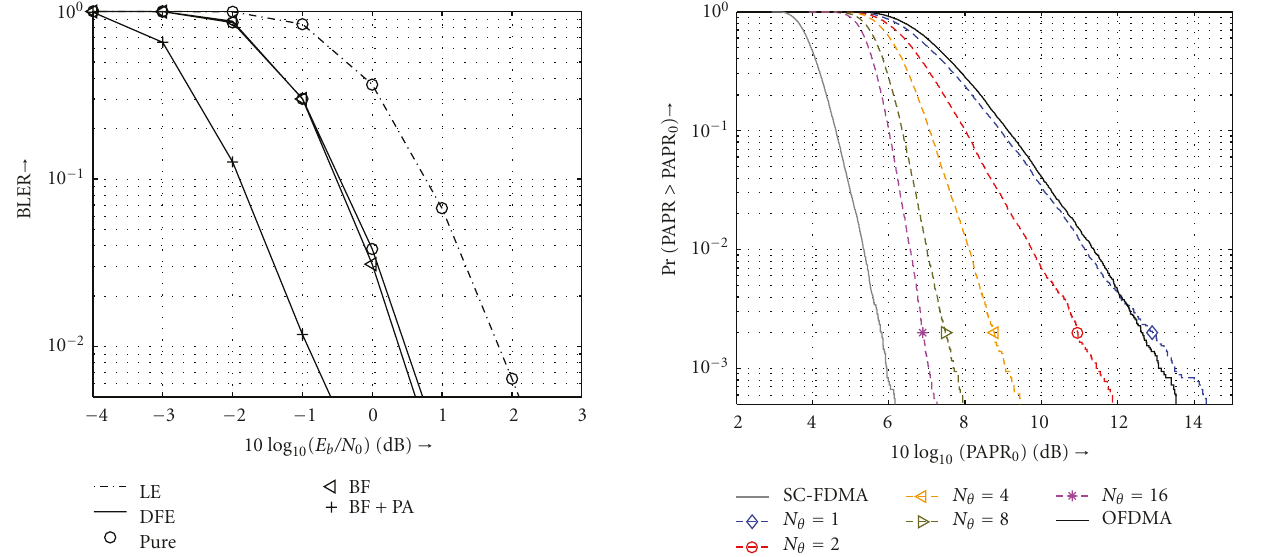
Figure 8: BLER for conventional MMSE-LE (dash-dotted line, “o”), conventional DFE (solid line, “o”), DFE with eigenbeamform- ing (solid line, “ ”), and DFE with eigenbeamforming and MMSE (cid:0) power allocation (solid line, “+”). Exponentially decaying channel profile, σ 2 [ κ ] ∼ e − κ/ 4 , κ ∈ { 0,1, ... ,20 } . n